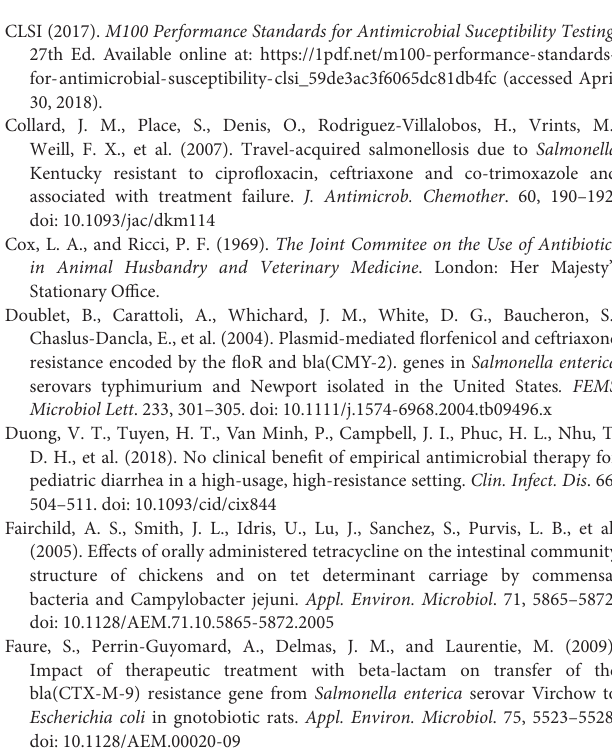
Supplemental Figure 1 | Detection of high molecular weight plasmids in antimicrobial-resistant Salmonella cultured from the environment of chickens